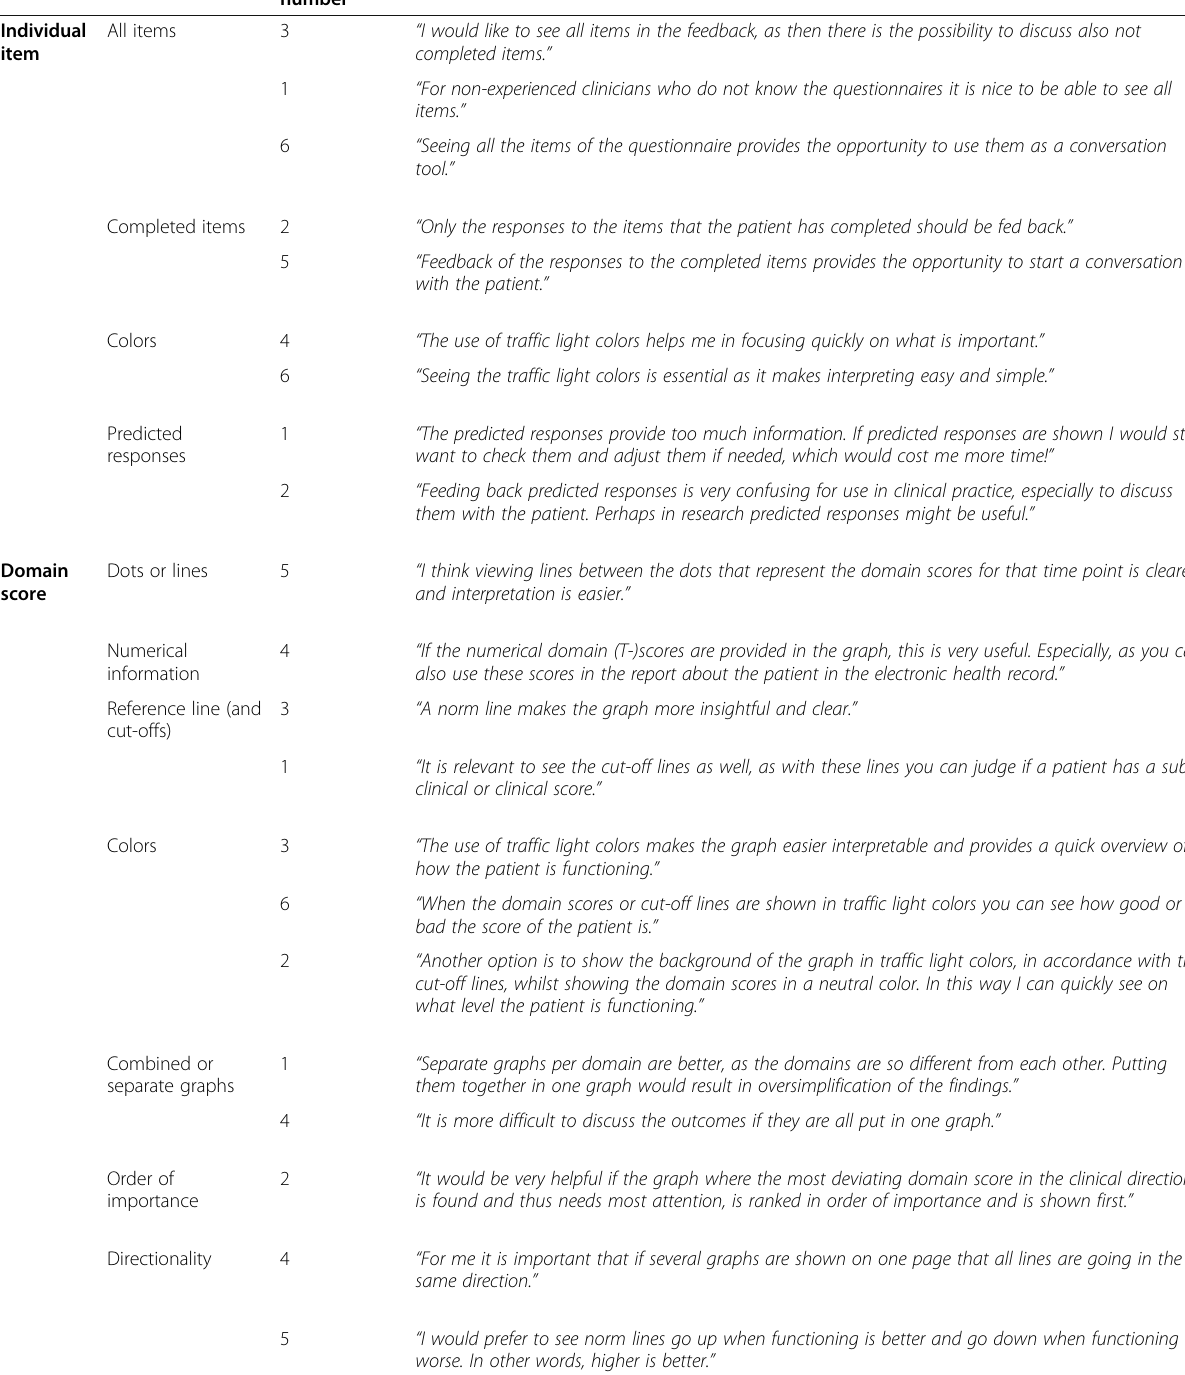
Table 2 Themes and examples found in focus groups Feedback Themes Focus group